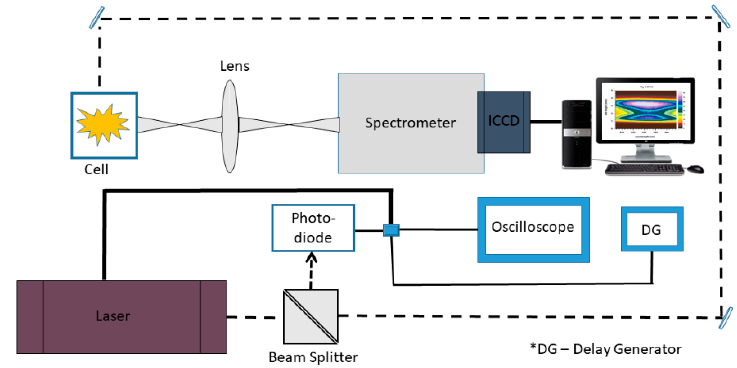
Figure 4. Experimental schematic for time ‐ resolved laser spectroscopy.